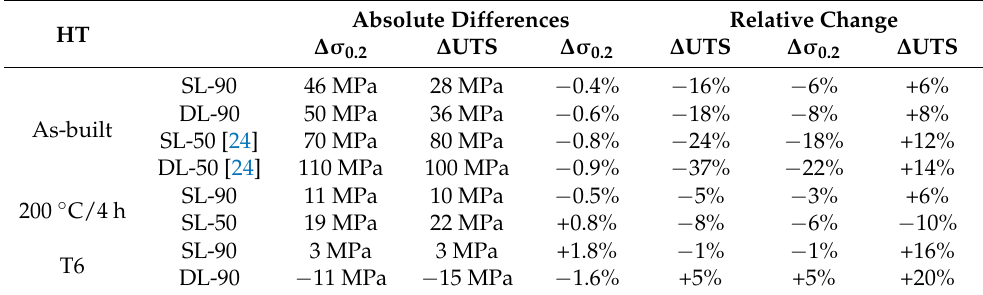
Figure 6. Tensile properties of AlSi10Mg samples: ( a ) as-built SL-90 and DL-90; ( b ) as-built SL-50 and DL-50; ( c ) SL-90 and SL-50 after 200 ◦ C/4 h; ( d ) SL-90 and SL-50 after T6 heat treatment. The blue arrows indicate the samples will be considered in Figure 7. Table 4. Variation of the mechanical properties from bottom to top of SL-90 and 50, DL-90 and 50 AlSi10Mg samples in as-built and heat-treated